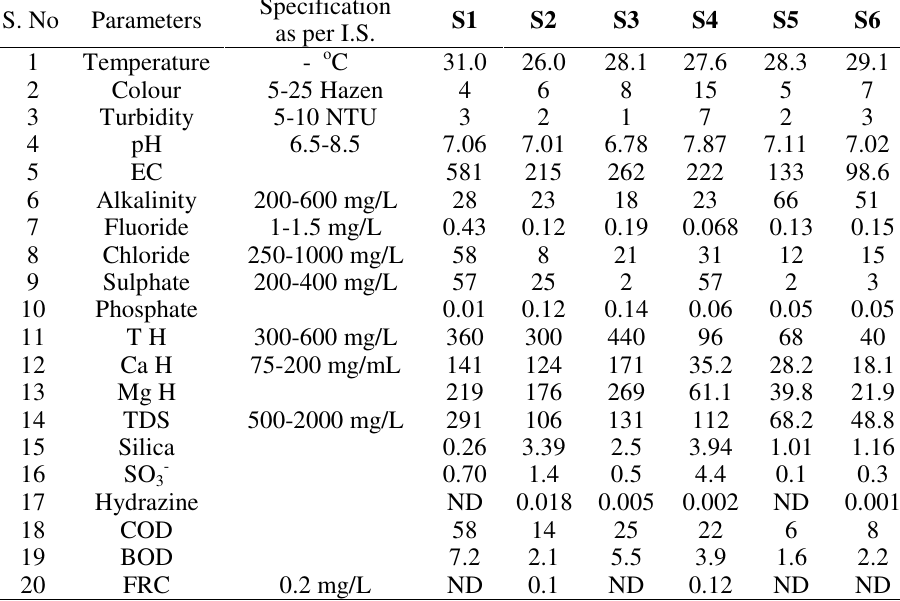
Table 1. Physicochemical characteristics of water of rivers Krishna Vijaywada ( S1 ) Gomati Lucknow ( S2 ) Hoogali Kolkata ( S3 ) Ganga Kasi ( S4 ) MahaNadi Katak ( S5 ) and Cauveri river ( S6 ) in